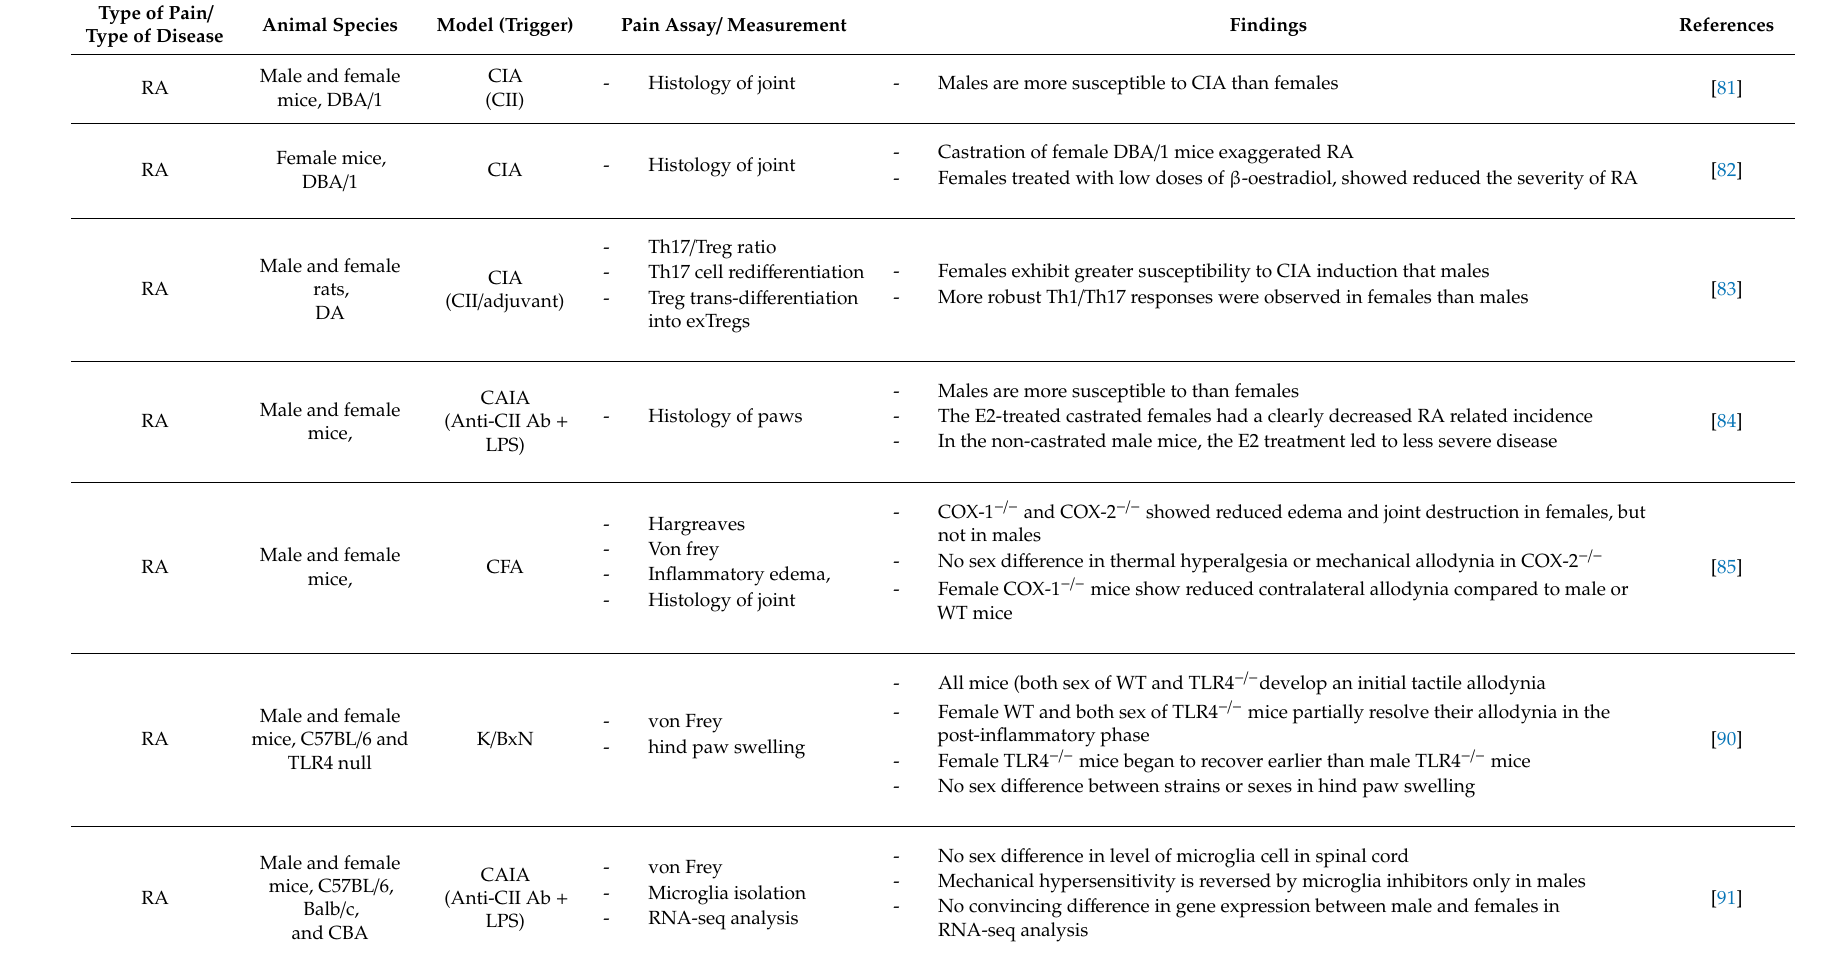
Table 3. Sex di ff erence in arthritis and arthritis pain in animal